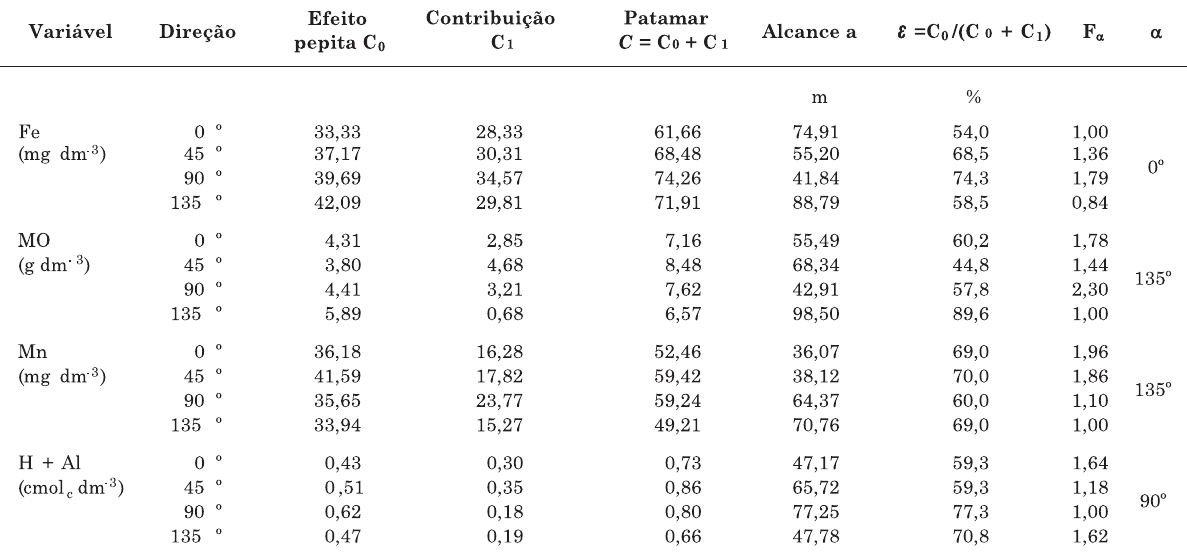
F : fator de anisotropia; a: ângulo de maior continuidade espacial; ε : efeito pepita relativo. a